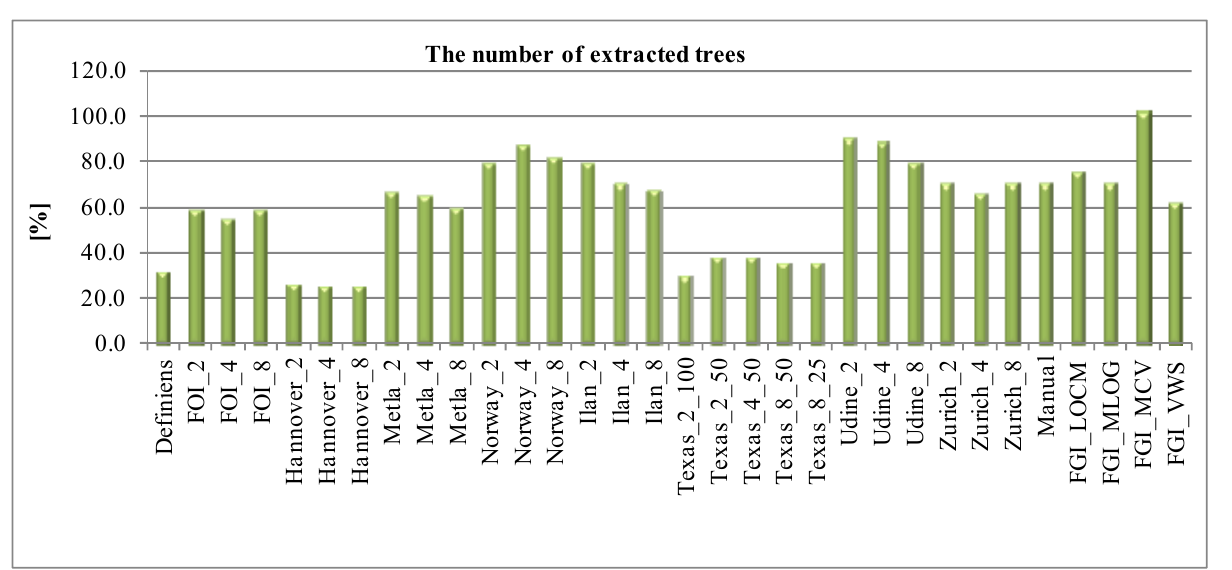
Figure 4. The number of extracted